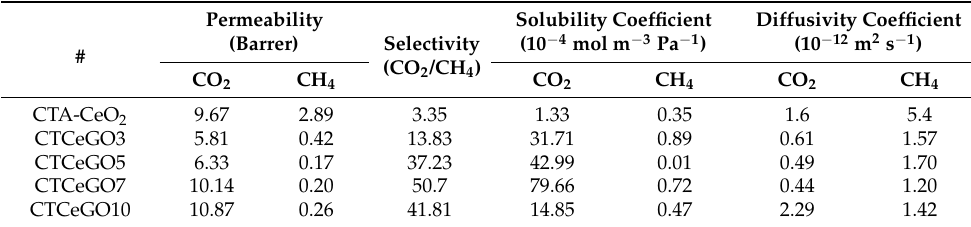
Table 2. Permeability, selectivity and their corresponding solubility and diffusivity values of the synthesized MMMs.